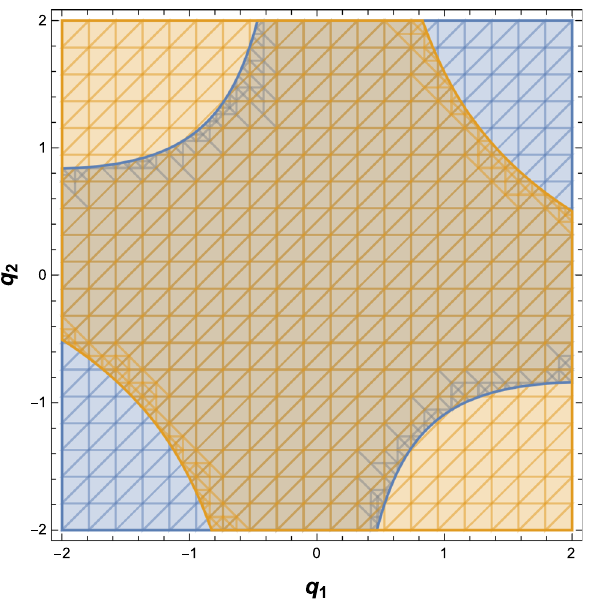
Fig. 1 The allowed region for choosing the values of the parameters q 1 and q 2 . The blue region is where h ( r ) > 0 and the orange region is where h ( r ) < 1. The values of q 1 and q 2 should be chosen from the intersection of these two regions. The values of γ and σ have been set to 1 and 0.8, respectively